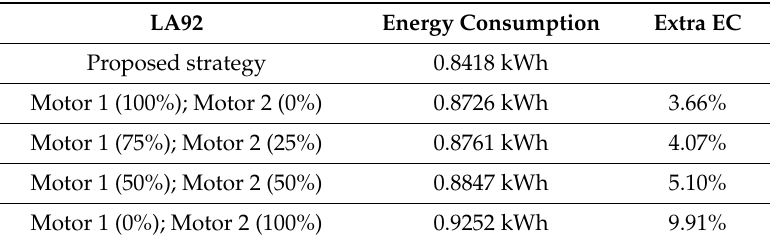
Table 2. Energy consumption